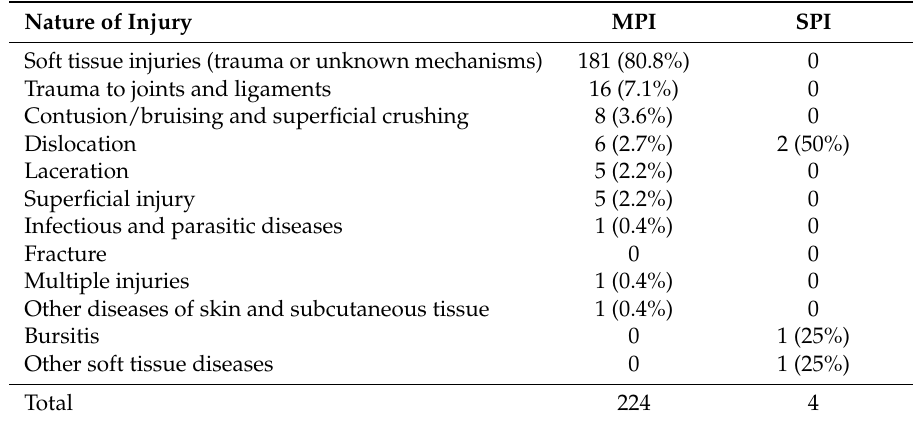
Other diseases of skin and subcutaneous tissue